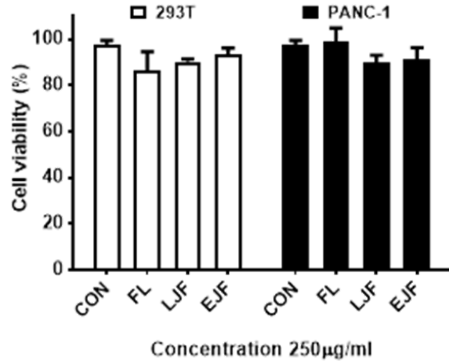
Figure 5. Effect of C. unshiu extracts on 293T and PANC-1 cell viability. Cells were grown in the presence of C. unshiu extracts. The cell viability was determined by an MTT assay in triplicate and expressed in percentage of control (100%).